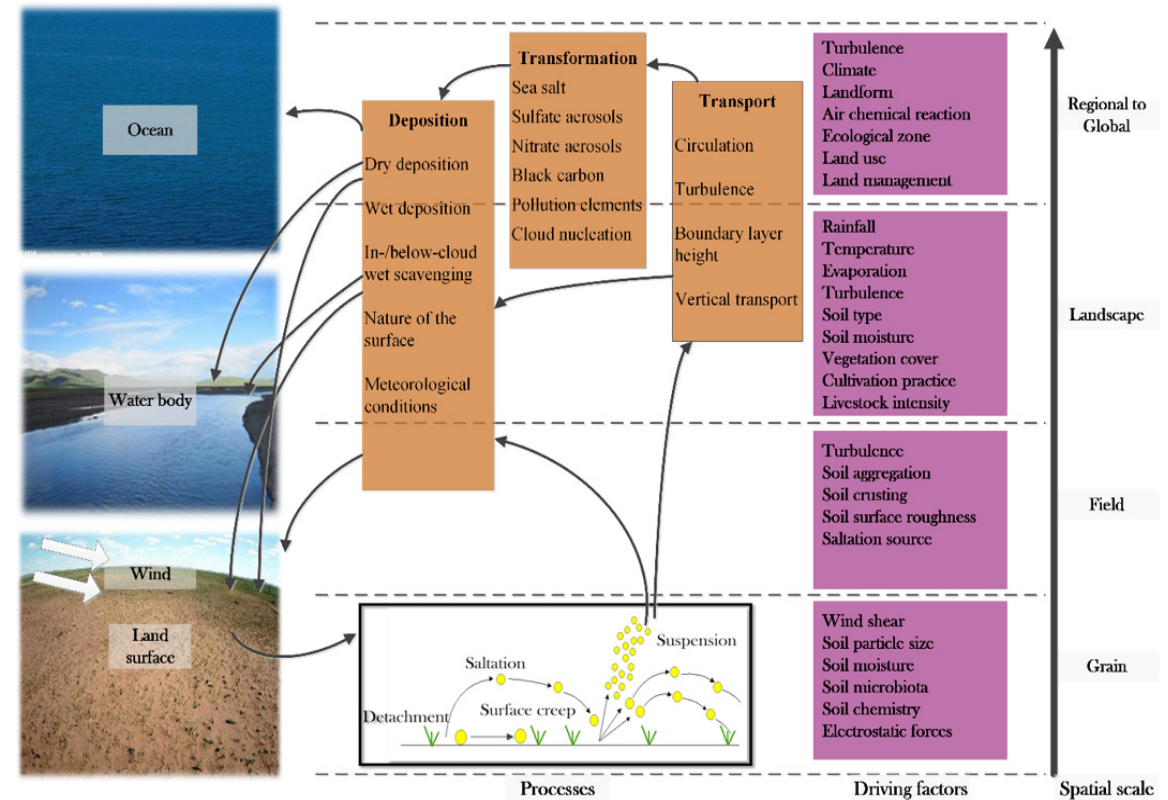
Figure 1. Dust processes and their controls at different spatial scales.